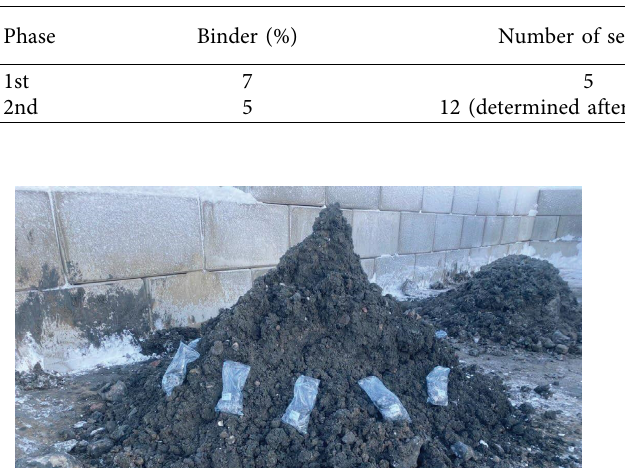
Table 3: Experimental plan.